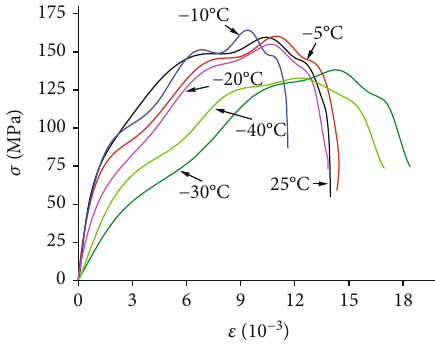
Figure 5: Stress-strain curve of granite under impact